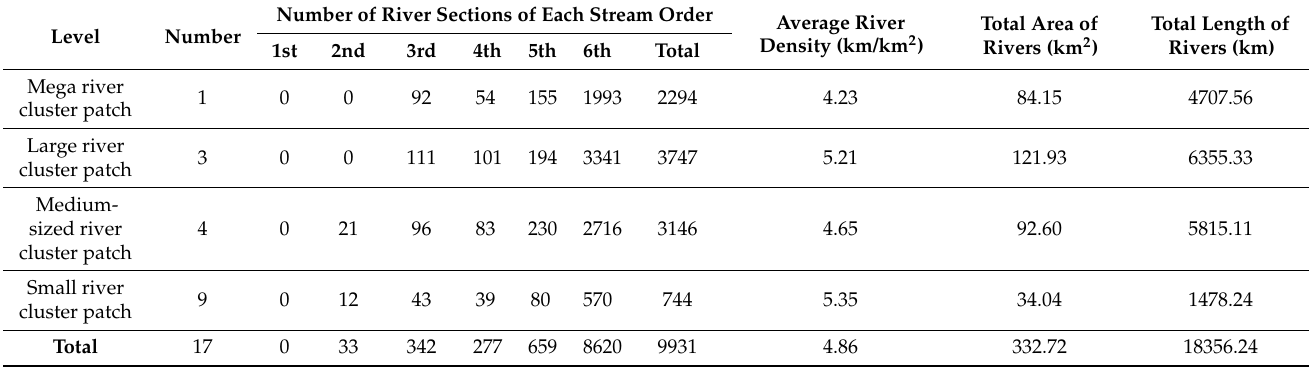
Table A1. Identification and extraction result statistics of river cluster patches at all levels.